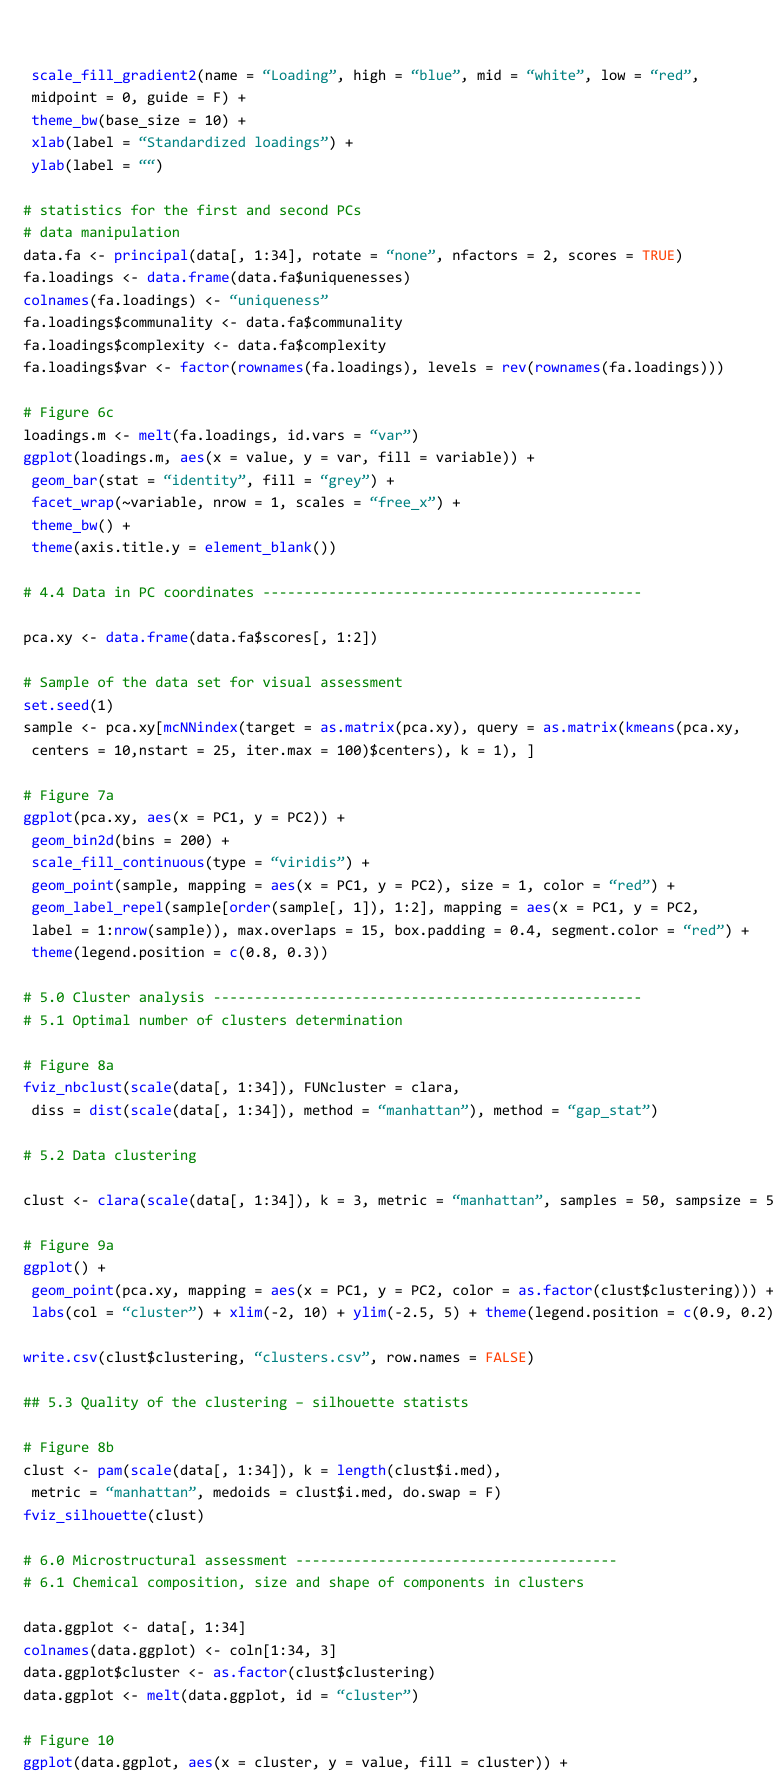
data.ggplot <- data[, 1:34] colnames(data.ggplot) <- coln[1:34, 3] data.ggplot$cluster <- as.factor(clust$clustering) data.ggplot <- melt(data.ggplot, id = “cluster”) # Figure 10 ggplot(data.ggplot, aes(x = cluster, y = value, fill = cluster)) + geom_violin()